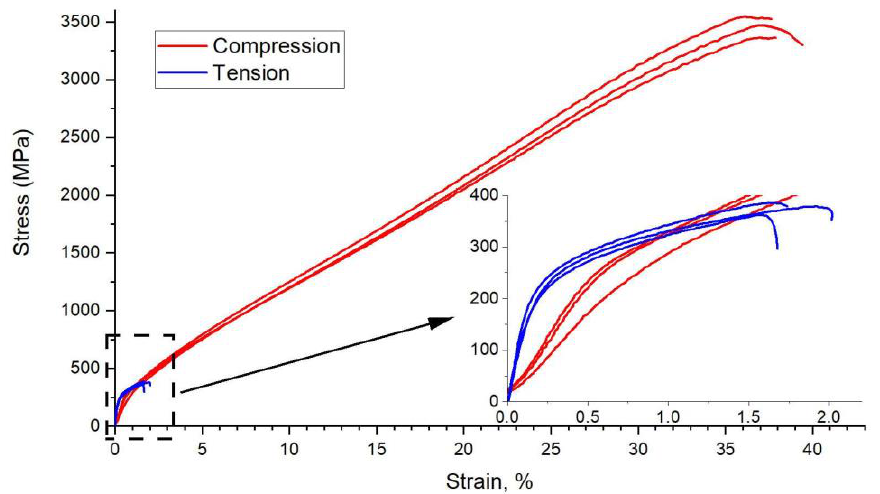
Figure 7. Microstructures of the specimens after deformation (in all cases, the marker length is 50 mm): ( a ) 0%, ( b ) 5%, ( c ) 10%, ( d ) 15%, ( e ) 20%, ( f ) 25%, ( g ) 30%, ( h ) 35%, and ( i ) 40%. Table 4. Mechanical properties of specimens during the tension and compression tests.